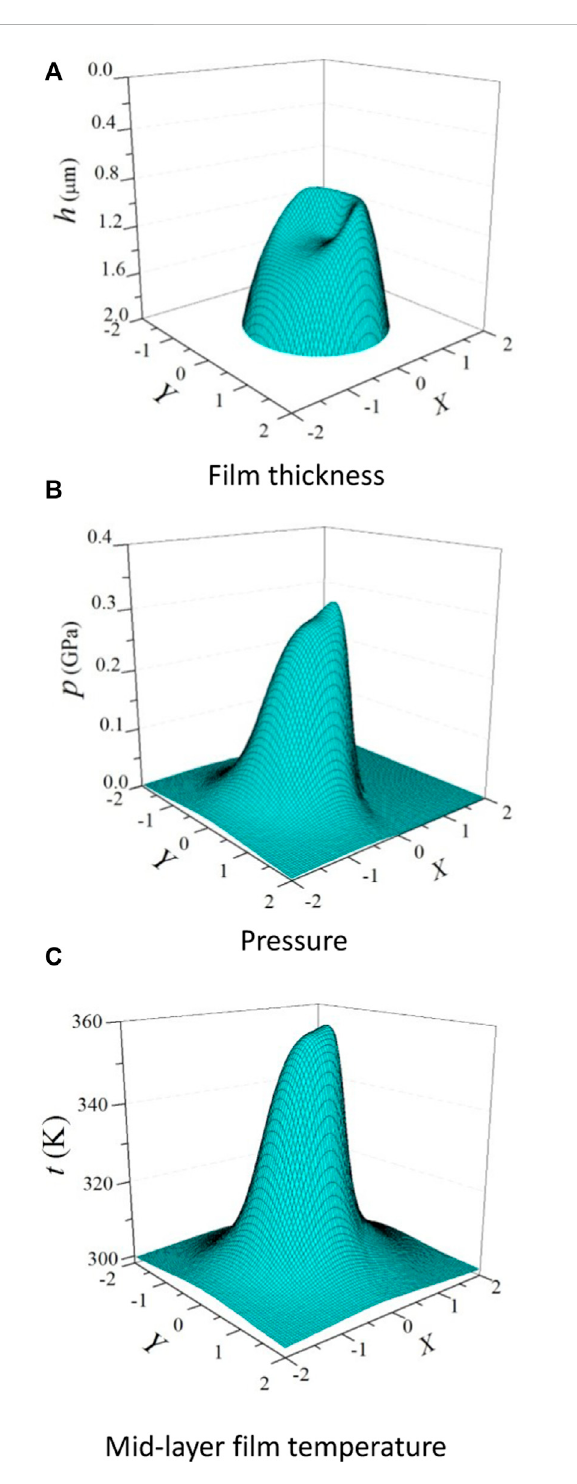
FIGURE 3 Typical numerical solutions for the spherical rib for R x 2 / R x 1 = 0.3, w = 320 N, and n i = 1,000 r/min. (A) Film thickness, (B) pressure, and (C) mid-layer fi lm